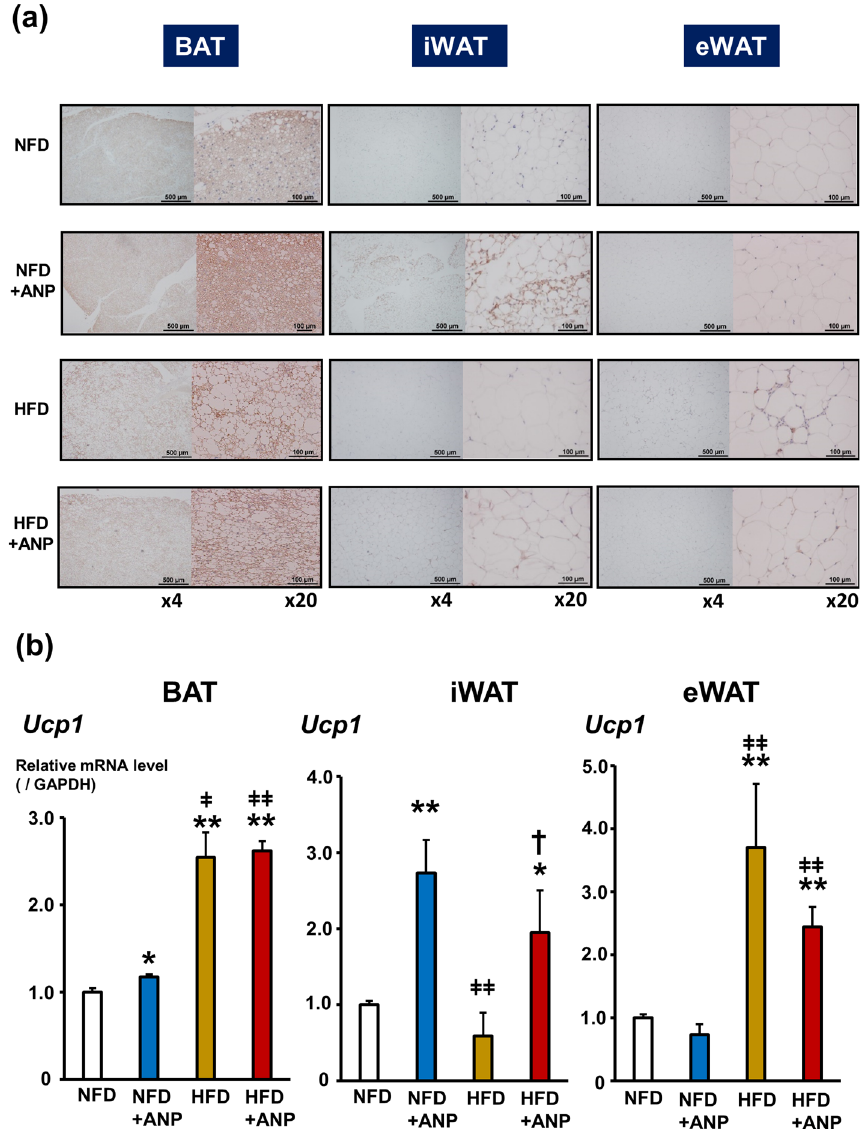
Figure 4. Effects of ANP treatment on UCP1 expression in adipose tissues. ( a ) Representative images of UCP1 immunostaining in each adipose tissue harvested from the indicated mice at three weeks after treatment with or without ANP (n = 3 each). The images were captured at a field lens magnification of × 4 (left, bars = 500 μm) and × 20 (right, bars = 100 μm). ( b ) The relative mRNA expression of UCP1 in each adipose tissue harvested from the indicated mice at three weeks after treatment with or without ANP (n = 5 each). The qPCR data were normalized to GAPDH. The data are shown as the fold change normalized to the levels found in NFD group. Data are mean ± SEM. * P < 0.05 and ** P < 0.01 versus NFD; † P < 0.05 versus HFD; ǂ P < 0.05 and ǂǂ P < 0.01 versus NFD + ANP. GAPDH, glyceraldehyde-3-phosphate dehydrogenase; UCP1, uncoupling protein